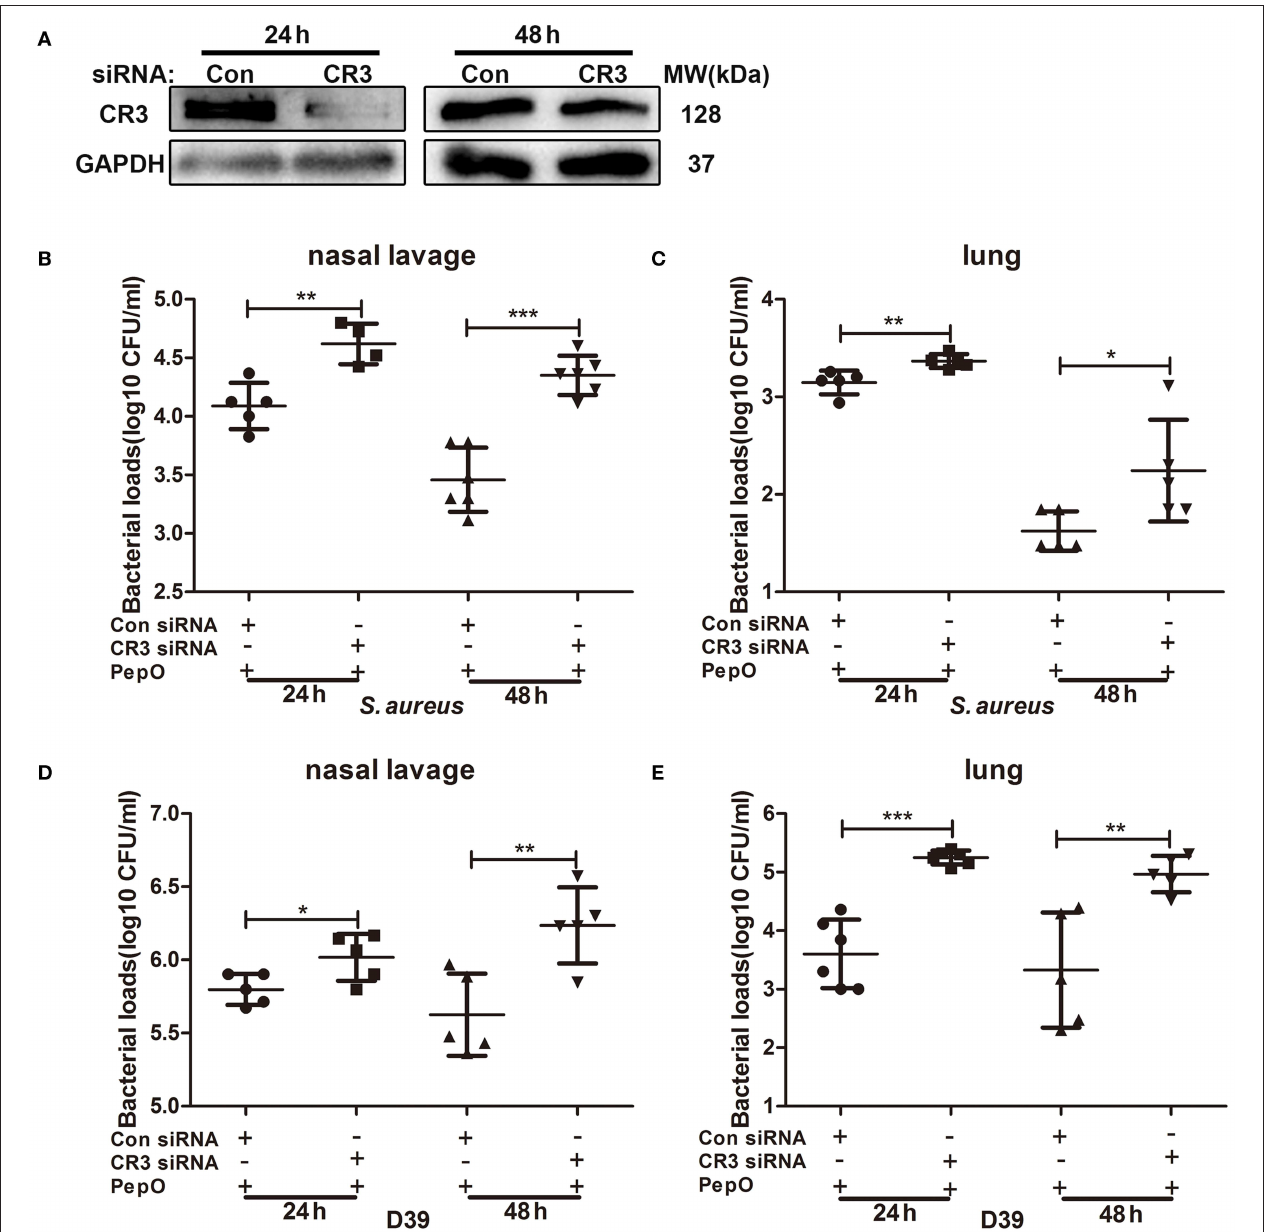
FIGURE 6 | The enhanced clearance of S. aureus and S. pneumoniae in PepO-treated mice is associated with the up regulation of CR3. (A) C57BL/6 mice were transiently transfected with CR3 siRNA or scrambled siRNA via intranasal administration for 24 and 48h. The effective knock down of CR3 was determined by WB analysis. (B–E) After transfected with CR3 siRNA or scrambled siRNA, mice were intranasally administrated with PepO for another 24h followed by an intranasal infection of S. aureus (B,C) or D39 (D,E) for 24 and 48h. The number of viable S. aureus or D39 in nasal lavage fluids and lungs were determined. Data are shown as averaged ( ± SD) bacterial loads of at least five mice per group from one representative experiment of two. Statistical analysis was performed by student’s t -test. *** p < 0.001, ** p < 0.01, * p < 0.05, Con, control.